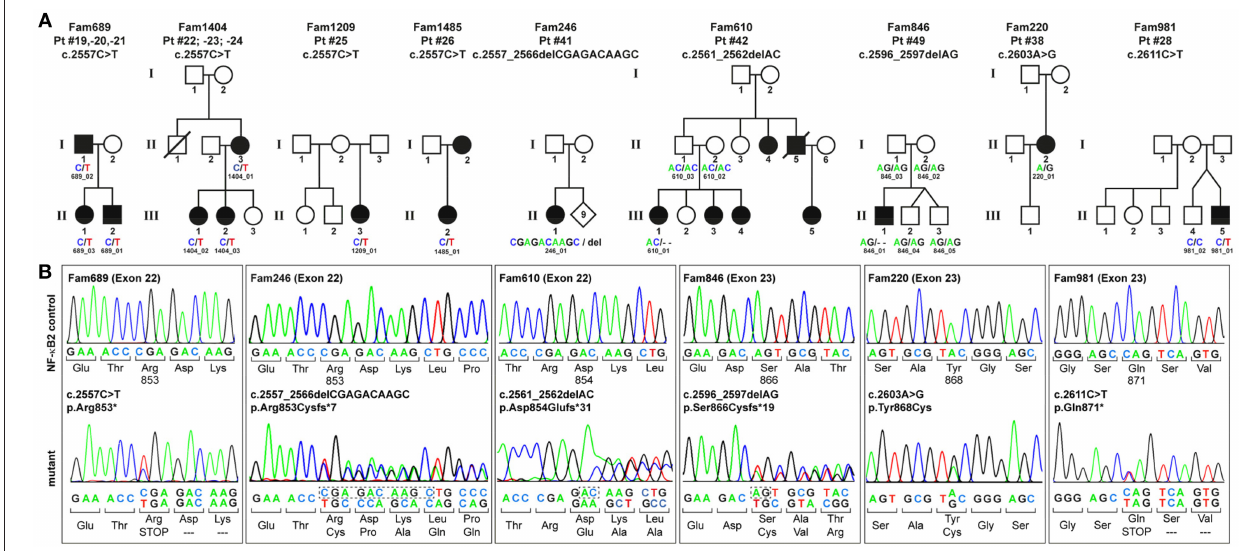
FIGURE 1 | PID-associated C-terminal NFKB2 mutations. (A) Pedigrees of the family members who participated in this study. Circles, female; squares, male; filled symbols, affected individual with PID; open symbol, healthy family member; slash, deceased individual. Family members who underwent genetic testing are indicated by IDs and sequence variants. (B) Sanger sequencing confirms that all NFKB2 mutations cluster within exons 22–23 and affect the C-terminus of the 900 amino acids precursor protein p100. The mutation in Fam689 is shown as a representative for all families harboring the p.Arg853 * hot-spot